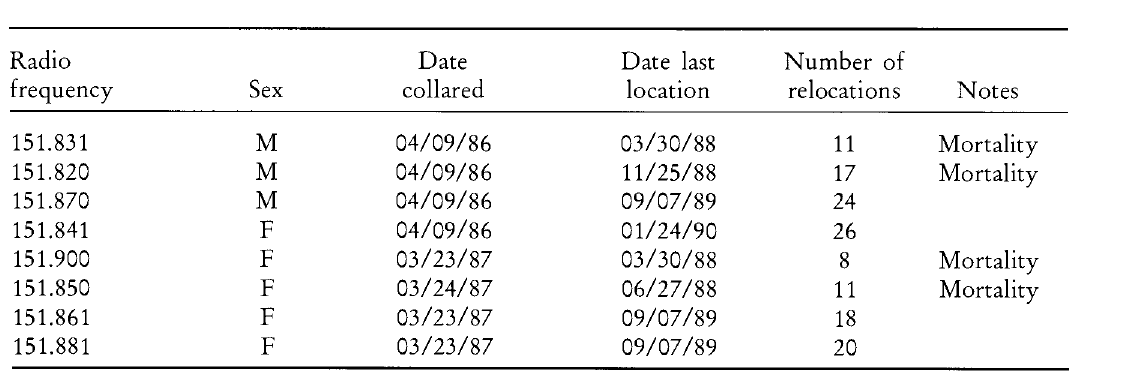
Table 1. Radio frequencies, sex, dates collared, last date of location, and number of relocations of radio-colla red caribou in the Galena Mountain Herd, 1986-90.